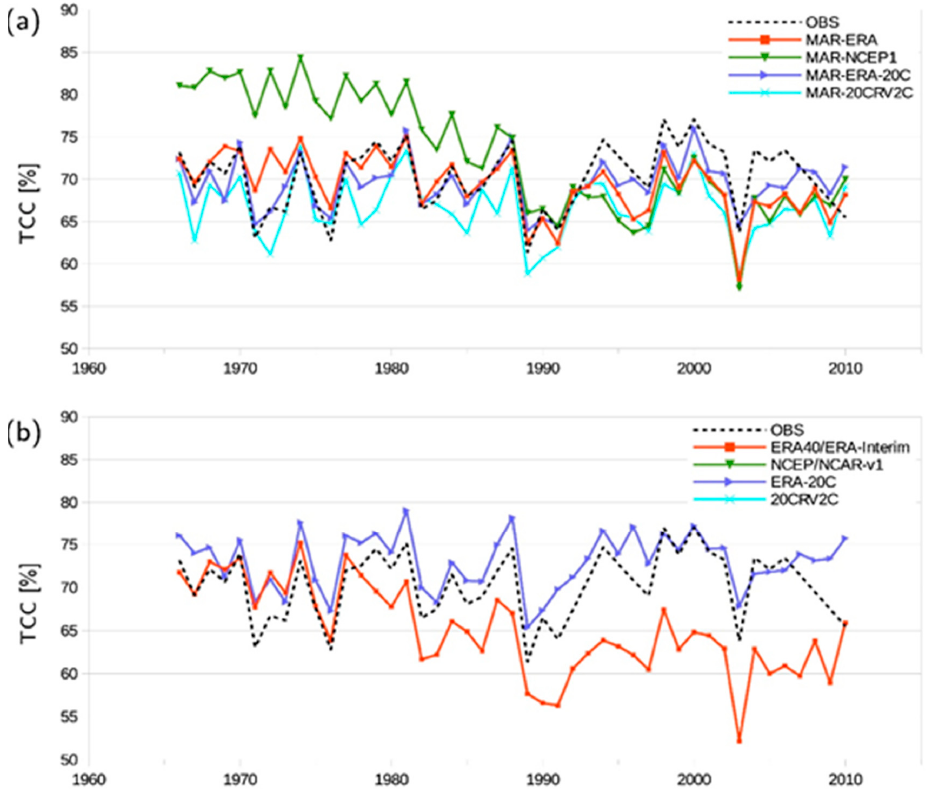
Figure 3. Time-series of the observed (at Saint-Hubert) and modelled TCC (at the nearest grid point to Saint-Hubert). TCC data from the National Centers for Environmental Prediction–National Center for Atmospheric Research (NCEP/NCAR-v1) and 20CRV2C were not available.